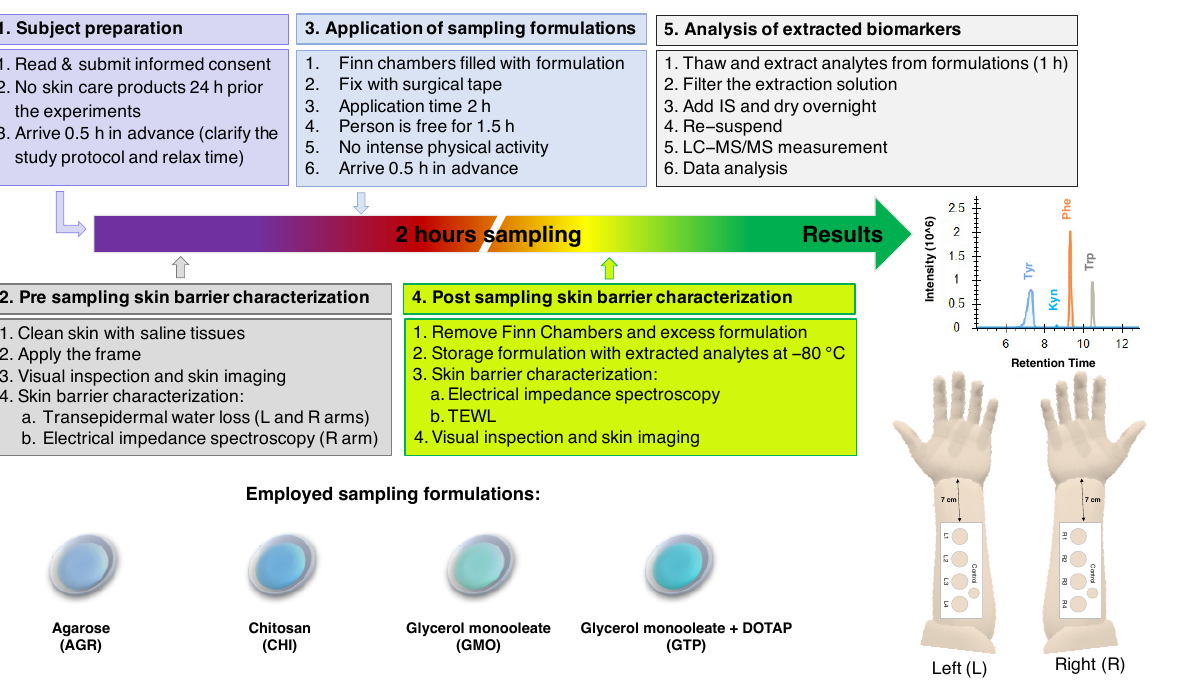
Figure 1. Graphical representation of the study